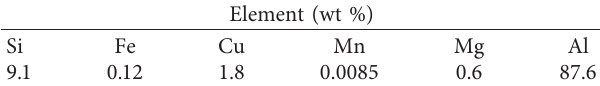
Table 1: Chemical composition of the as-received 354